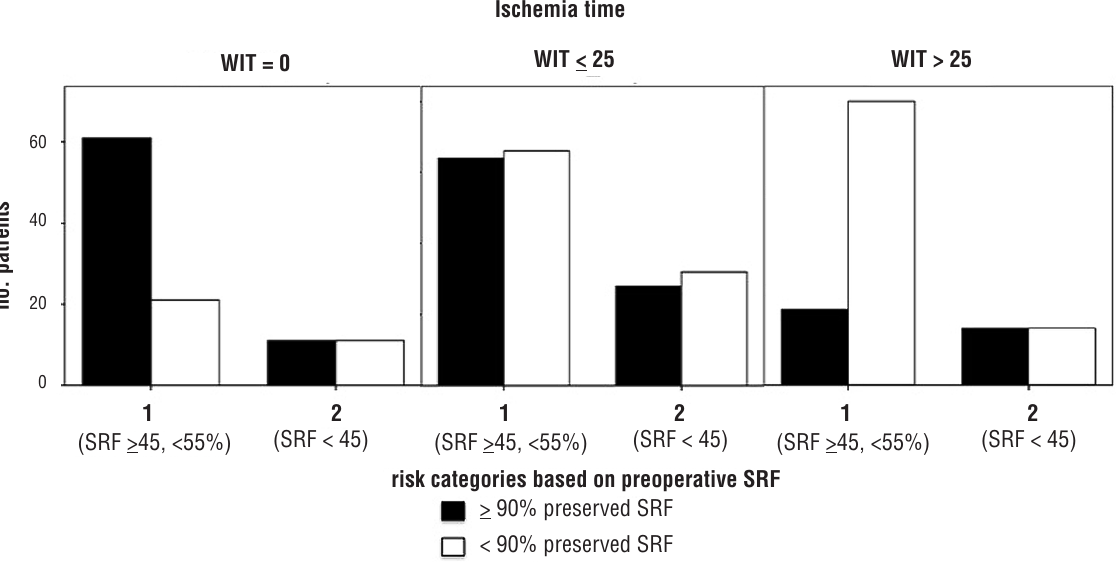
Figure 2 - Bar charts depicting patients stratified according to the warm ischemia time. In every chart on the right risk category 1 patients (with baseline split renal function at renal scan ranging between 45 and 55%); on the left risk category 2 patients (with baseline split renal function at renal scan < 45%); patients with preservation of ≥ 90% of the baseline Split Renal Function are represented in the blue bars; patients with preservation of < 90% of the baseline Split Renal Function are represented in the green